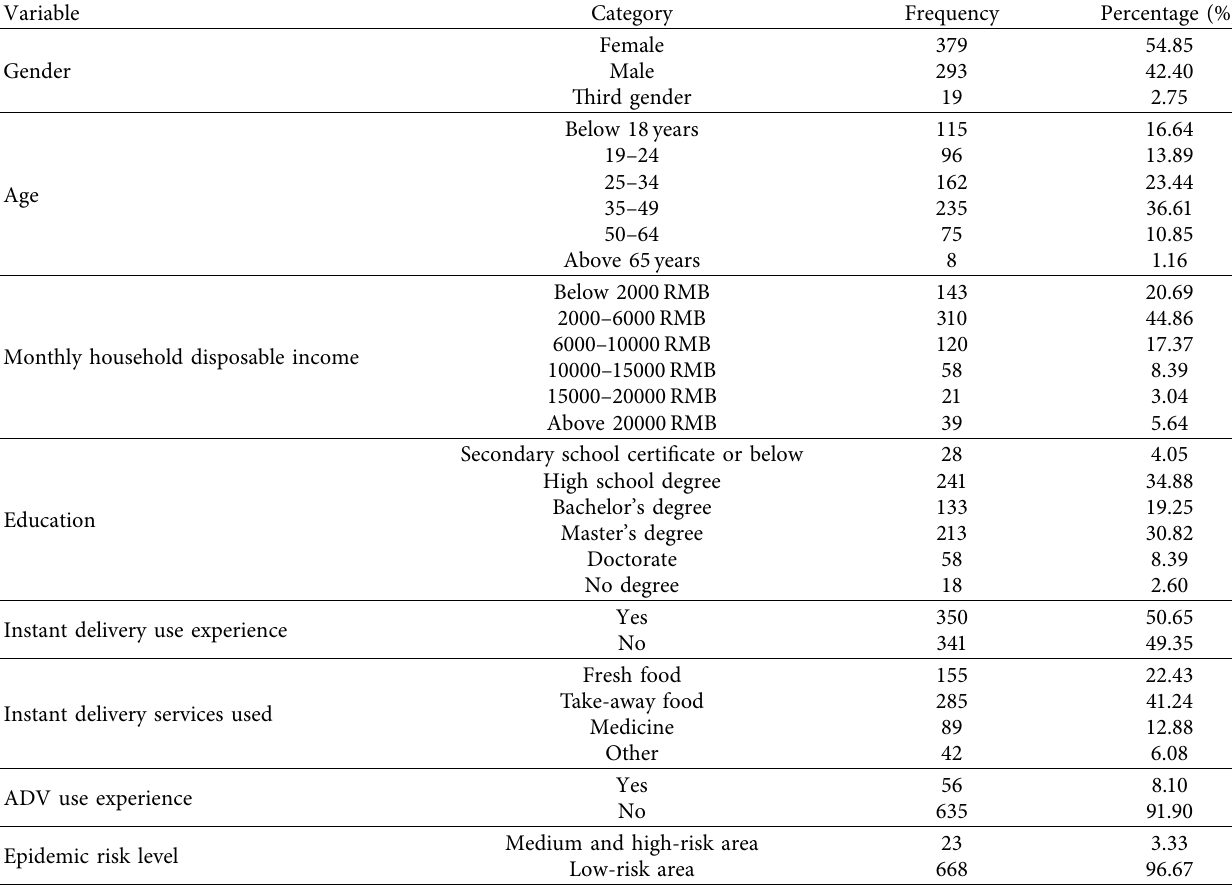
Table 4: Demographic details of